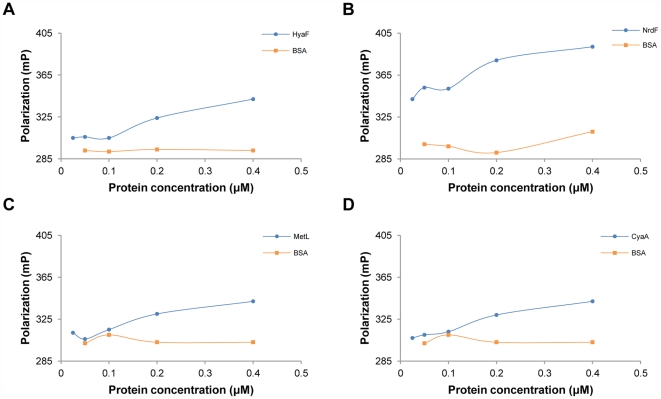
Validation of the interactions between LfcinB and proteins using fluorescence polarization assays.FP assays provide a homogeneous-based environment for a binding test, eliminating immobilization and separation procedures. We used FP assays to conduct screening for protein-peptide interactions. The rotation of fluorescently labeled LfcinB (a small molecule) is faster and hence causes the emitted light to be depolarized. When LfcinB binds to the target proteins, the molecular weight becomes larger and makes the rotation slow. Thus, the degree of polarization becomes higher. In FP assays, the polarization values of the tested proteins were compared with BSA (negative control). The blue circle is a sample and the orange square is BSA. Sixteen out of the 153 proteins have apparent differences from BSA. A. HyaF, B. NrdF, C. MetL and D. CyaA are representative FP results.